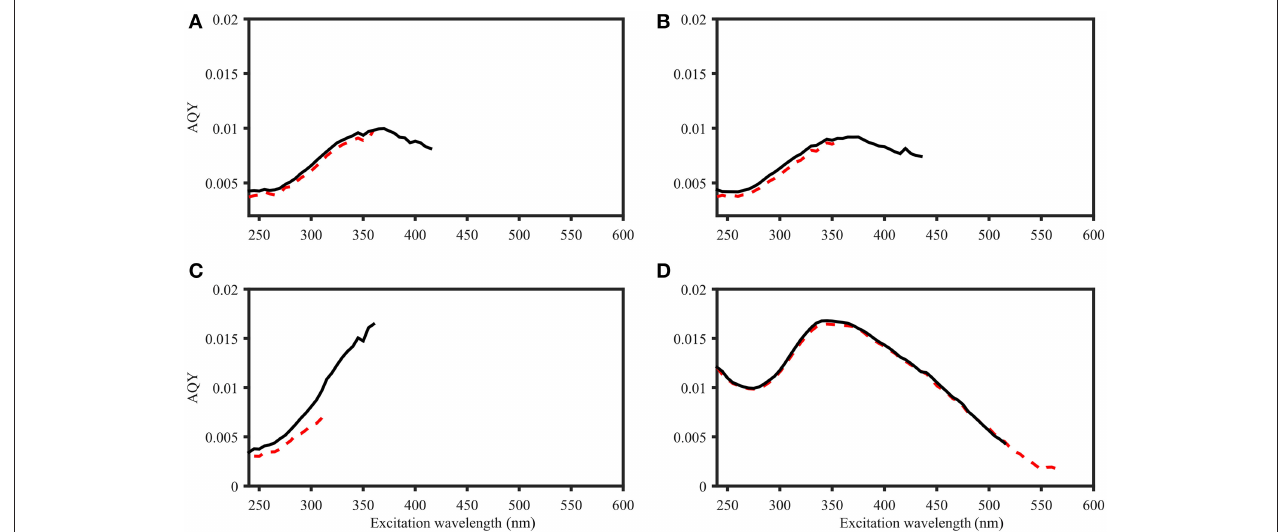
FIGURE 4 | Comparison of AQY calculations for four samples. Black line: Zero-intercept approach. Red dashed line: Variable-intercept approach. (A–C) Norwegian shelf DOM, water depth: 30, 10, and 200m ( A–C , respectively). (D) 2.5mg L − 1 Suwannee River XAD-8 fulvic acid extract. Figures do not include error bars for ease of viewing, but in all cases, AQY values of the two calculation approaches were within the precision estimates (e.g., + / − 0.22 ∗ 10 − 4 and 0.61 ∗ 10 − 4 for zero- and variable-intercept approach in (D) ,